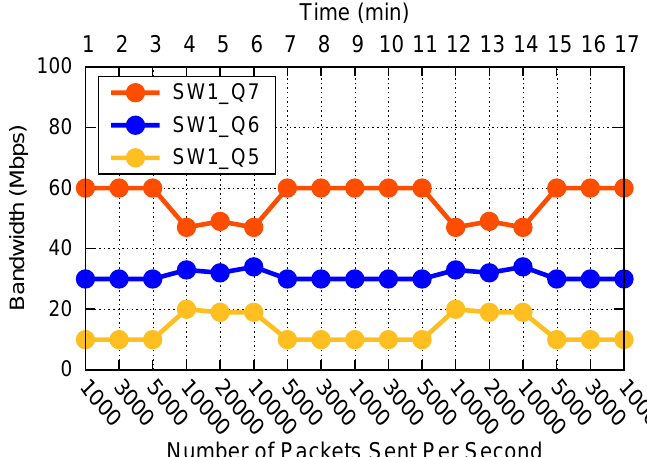
Figure 10. Three priority queues